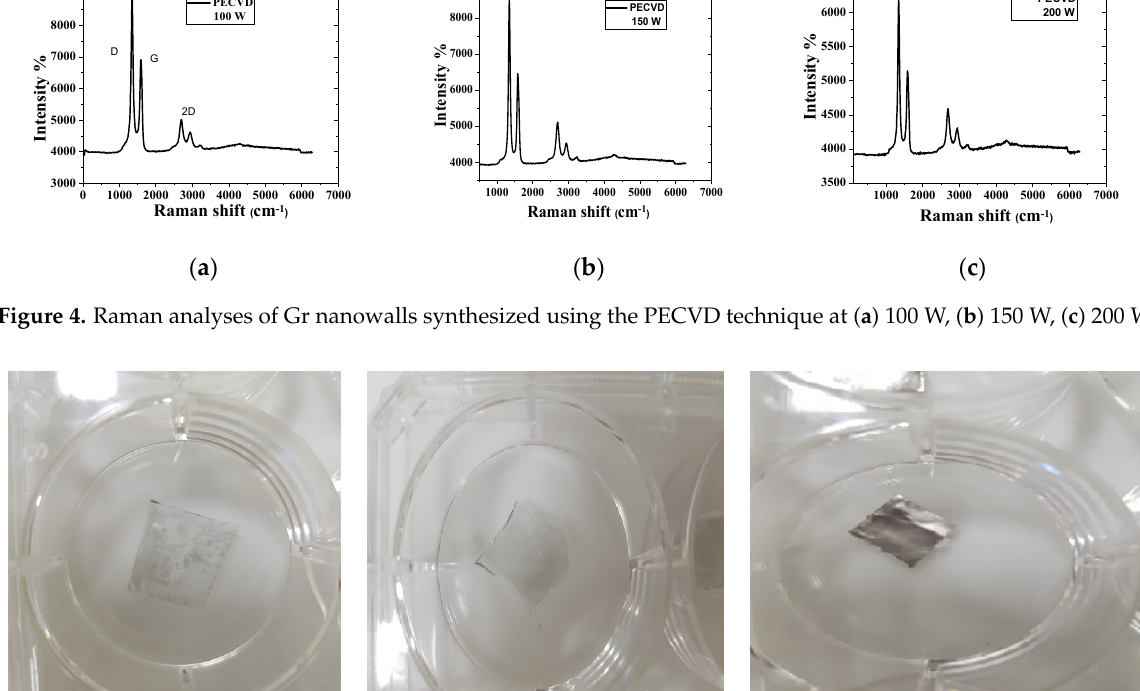
Figure 6. SEM images of PECVD grown graphene nanowalls at different magnifications at ( a ) ×65, ( b ) ×100, and ( c ) ×150. Figure 7 exhibits the cell viability (%) of E. coli and Figure 8 shows the cell viability (%) of S. aureus . The antibacterial activities of the samples against E. coli and S. aureus are shown in Figure 9 and Figure 10, respectively. It is observed that GrNs on the substrates show different antibacterial activities.